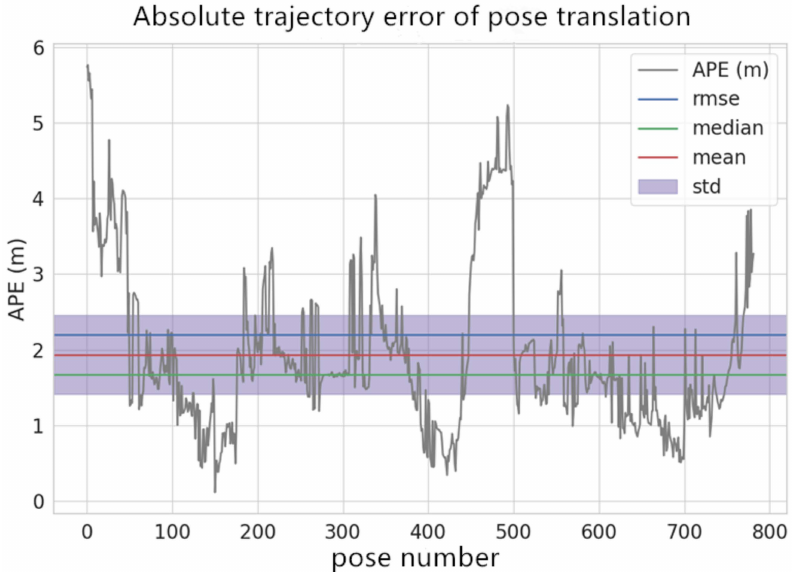
Figure 10. Evo tool APE evaluation results for FastGICP algorithm.